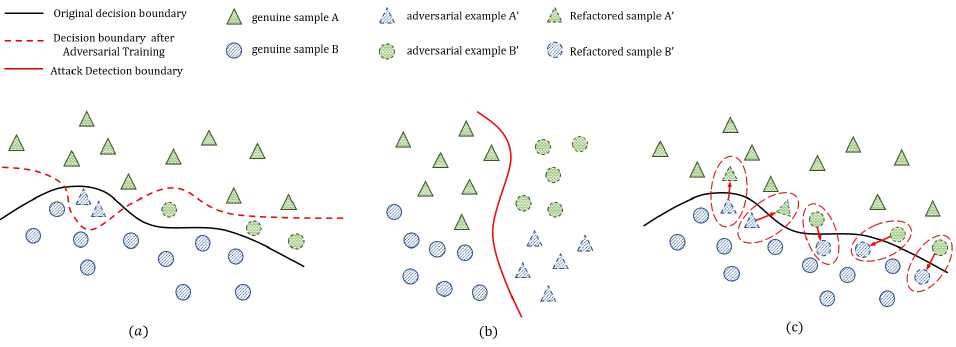
Figure 11. The two-dimensional visualization of different defense strategies. Figure ( a ) represents the adversarial training with the aim of finding robust decision bounds. Figure ( b ) represents attack detection, distinguishing clean samples from adversarial samples. Figure ( c ) represents